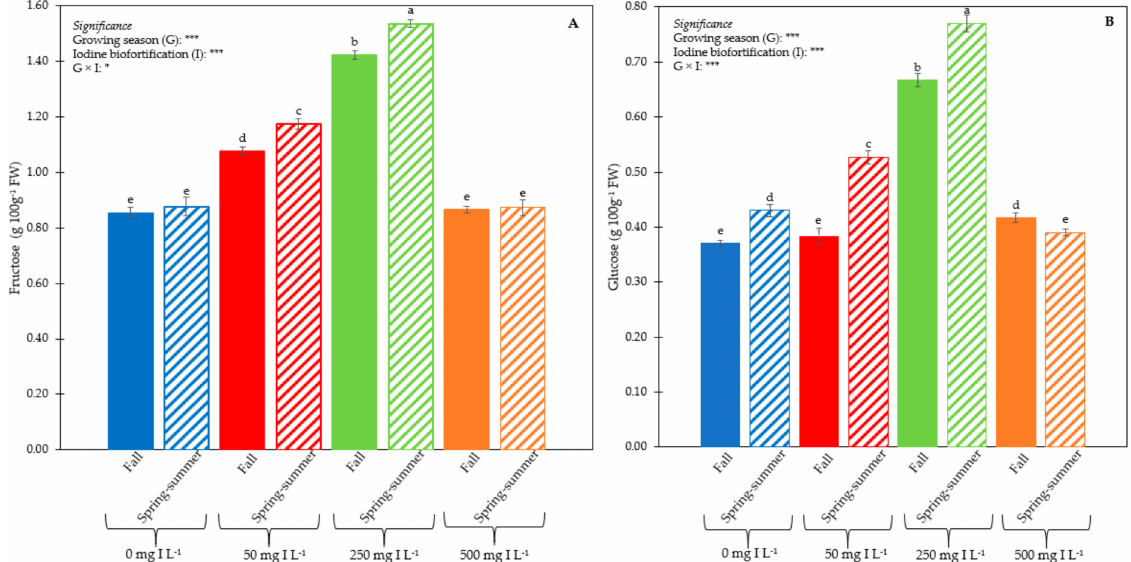
Figure 5. Fructose ( A ) and glucose ( B ) concentration as influenced by combining the growing season (fall or spring–summer) and iodine supply (0, 50, 250 or 500 mg L − 1 ) in curly endive. Different letters indicate significant differences at p ≤ 0.05. *, *** significant at 0.05 and 0.001, respectively.